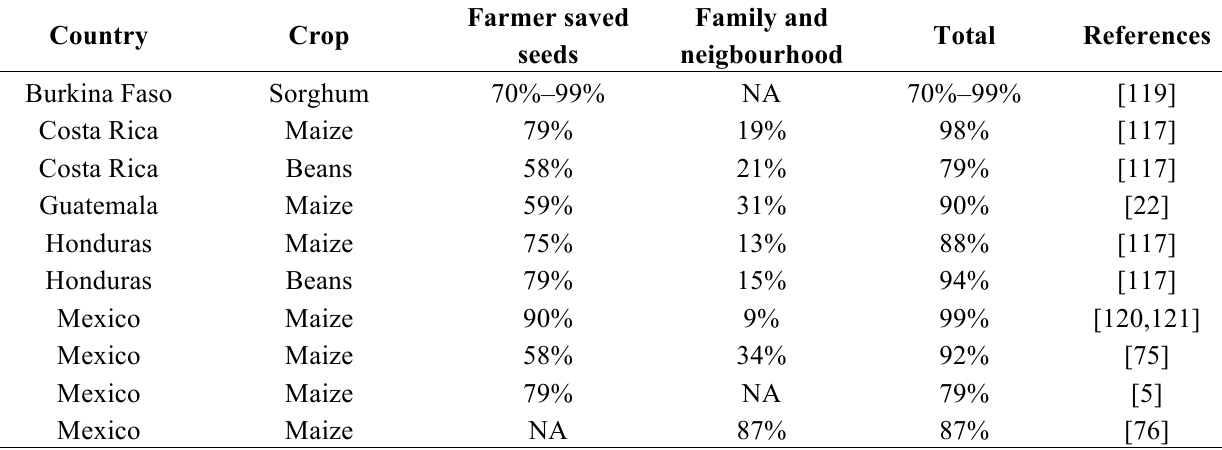
Table 1. Sources of seeds in traditional